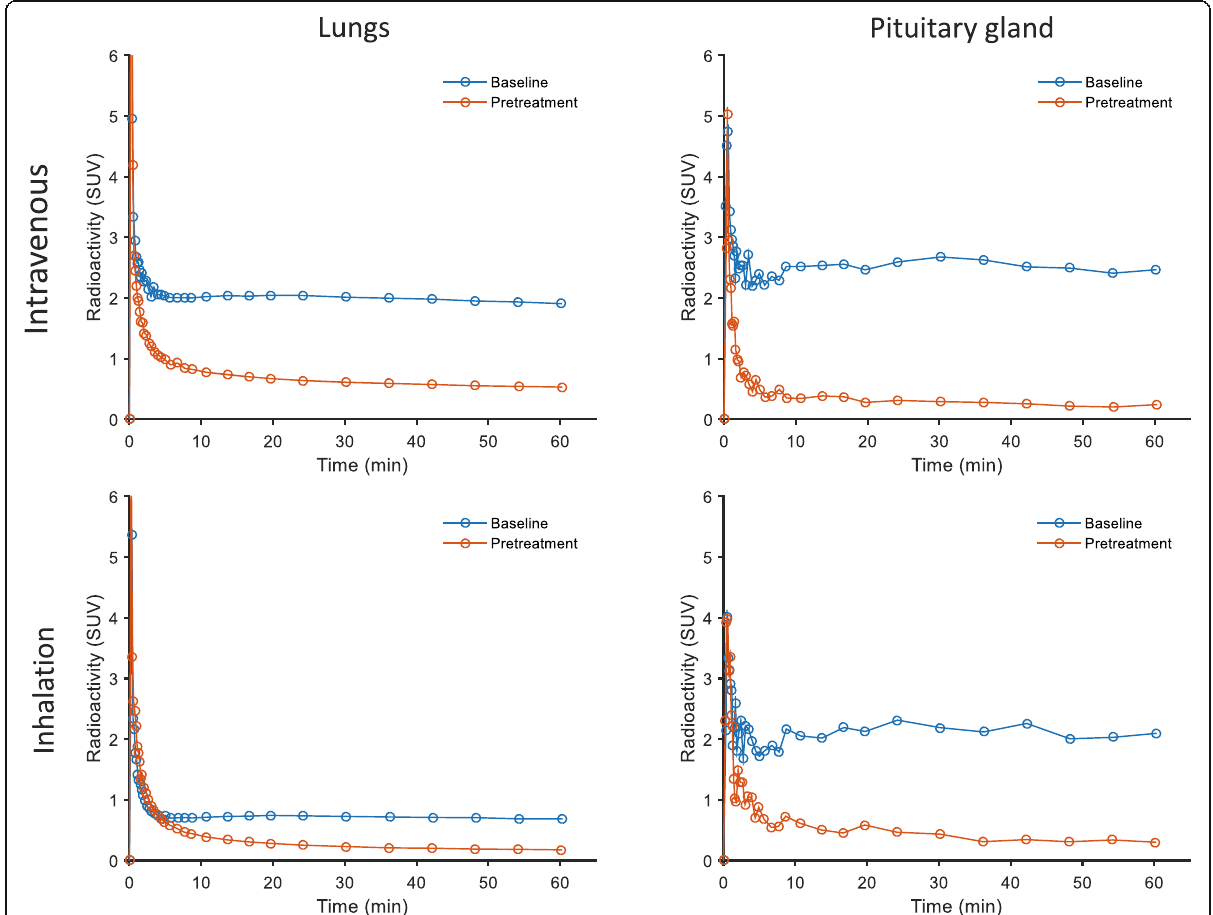
Fig. 4 Example time-course for radioactivity in lungs and pituitary gland following intravenous injection of [ 11 C]VC-002. The top TACs represent organ radioactivity at baseline and after post-dosing via intravenous infusion of ipratropium (NHP#1, 30 μ g/kg). The bottom TACs represent organ radioactivity at baseline and after post-dosing via inhalation of ipratropium (NHP#3, 150 μ g/kg)